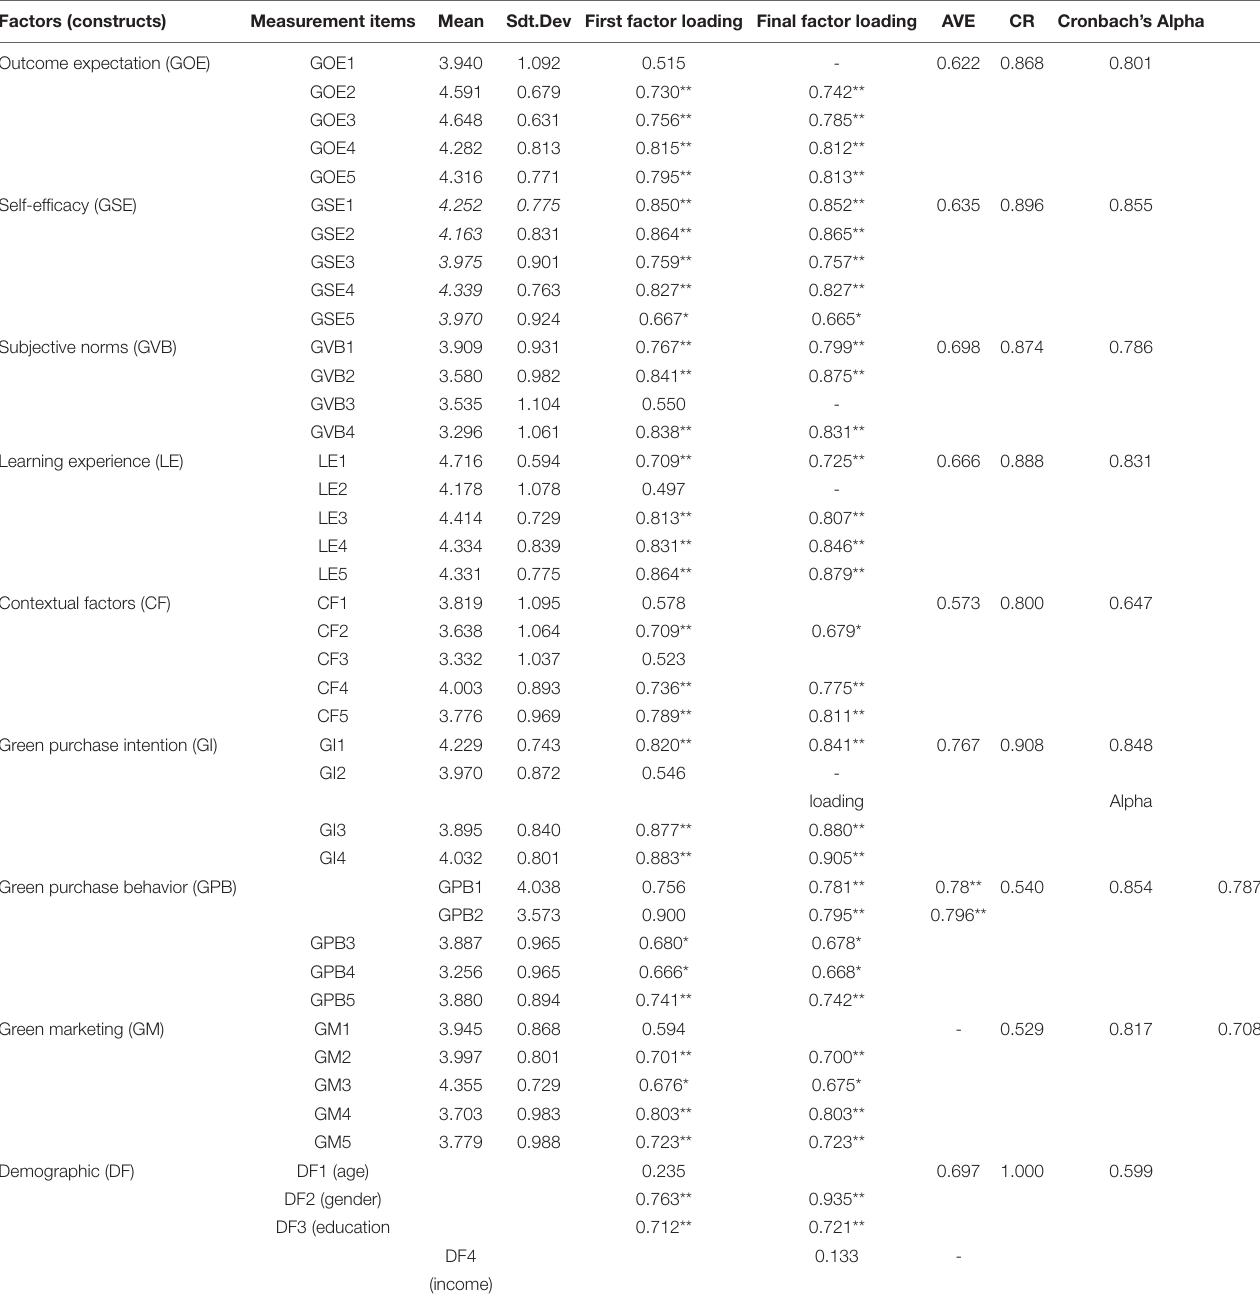
TABLE 3 | The initial and final factor loading of each item and the value of AVE, CR and Cronbach’s α of each factor (construct). Factors